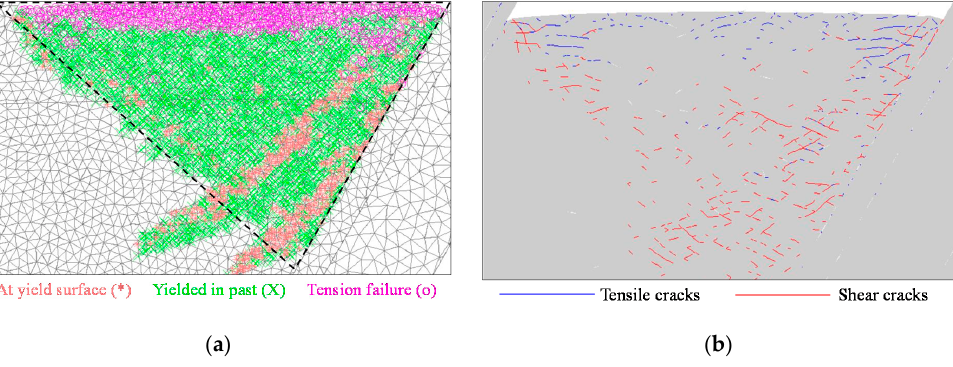
Figure 10. Simulated fracture patterns in bottom coal of working face: ( a ) Plastic state of zones in bottom coal; and ( b ) Distribution of cracks (shear cracks in red and tensile cracks in blue) in bottom coal.